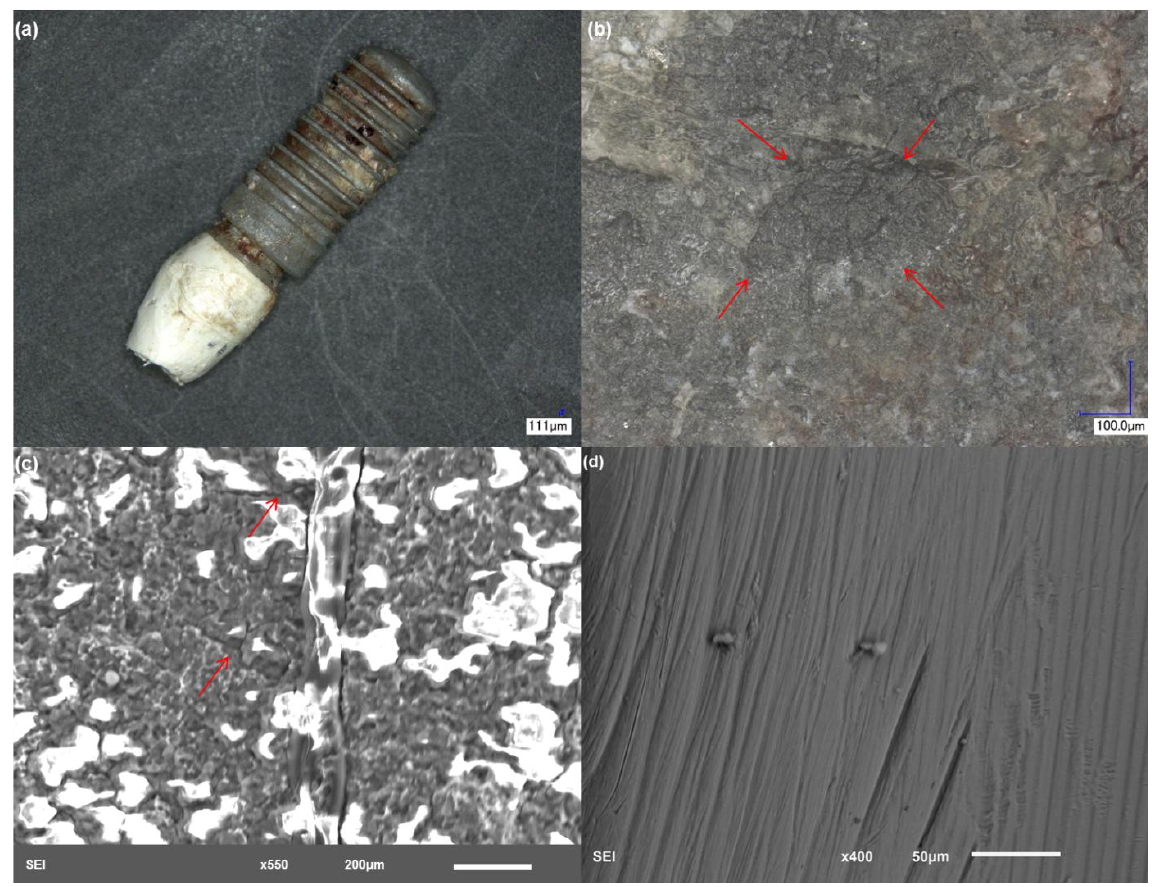
Figure 5. Structure of implant 4. ( a ) Low magnification showing the gross features of the implant and bone attachment to the bottom part of the surface; ( b ) discoloration is also evident in this example with severely deformed areas; ( c ) implant rough interface with evidence of crack development, which was filled with biological material; and ( d ) higher magnification of an exposed area of the abutment with